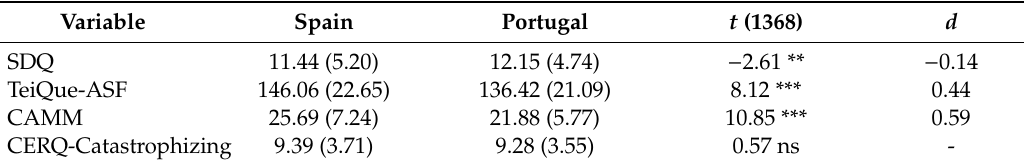
Table 2. Variable mean scores by country.